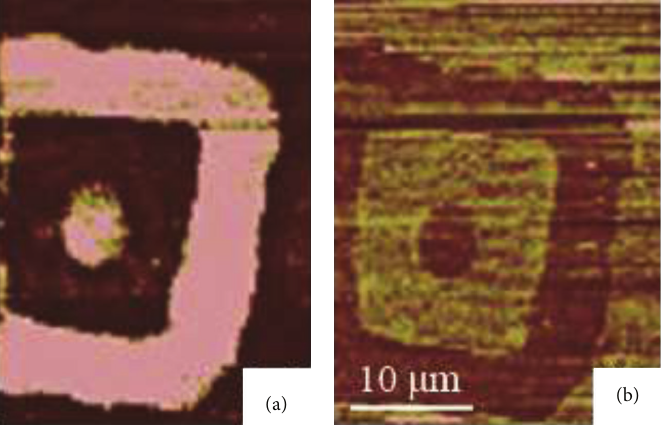
Figure 4: The lateral force images of MHA SAMs in (a) air (20% RH) and (b) water. The square pattern is the MHA SAM pattern, and the rest of the part is the gold substrate. The scale bar in (b) is the same for both images.